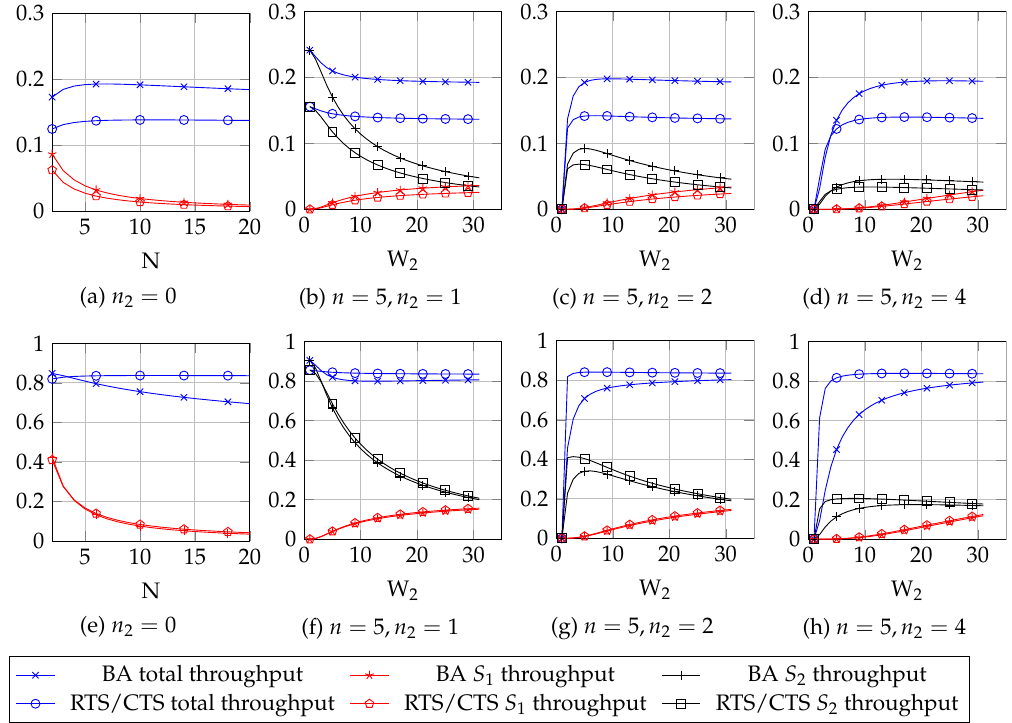
Figure 2. Throughput ( S ) results for the simulations using Bianchi’s model with short payload, T p , l , (a-d) and long payload, T p , l , (e-h). In cases (a) and (e), there are no malicious stations; in cases (b-d) and (f-h) there are malicious stations. S 1 is the throughput of normal stations, S 2 the throughput of malicious stations.